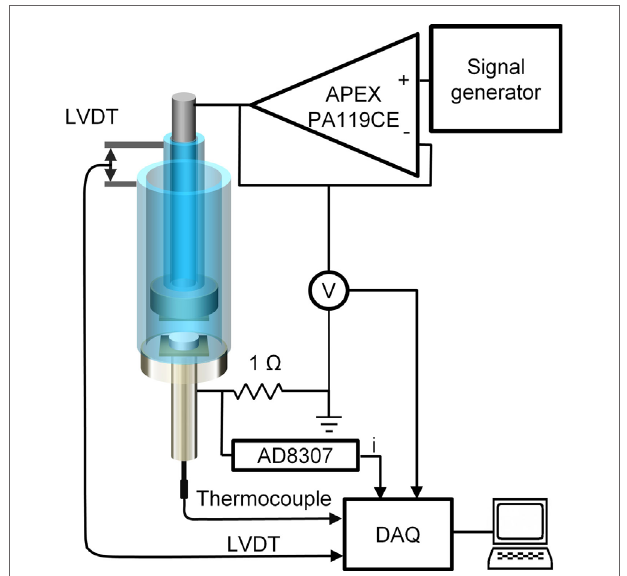
FigUre 1 | sintering and data acquisition set-up